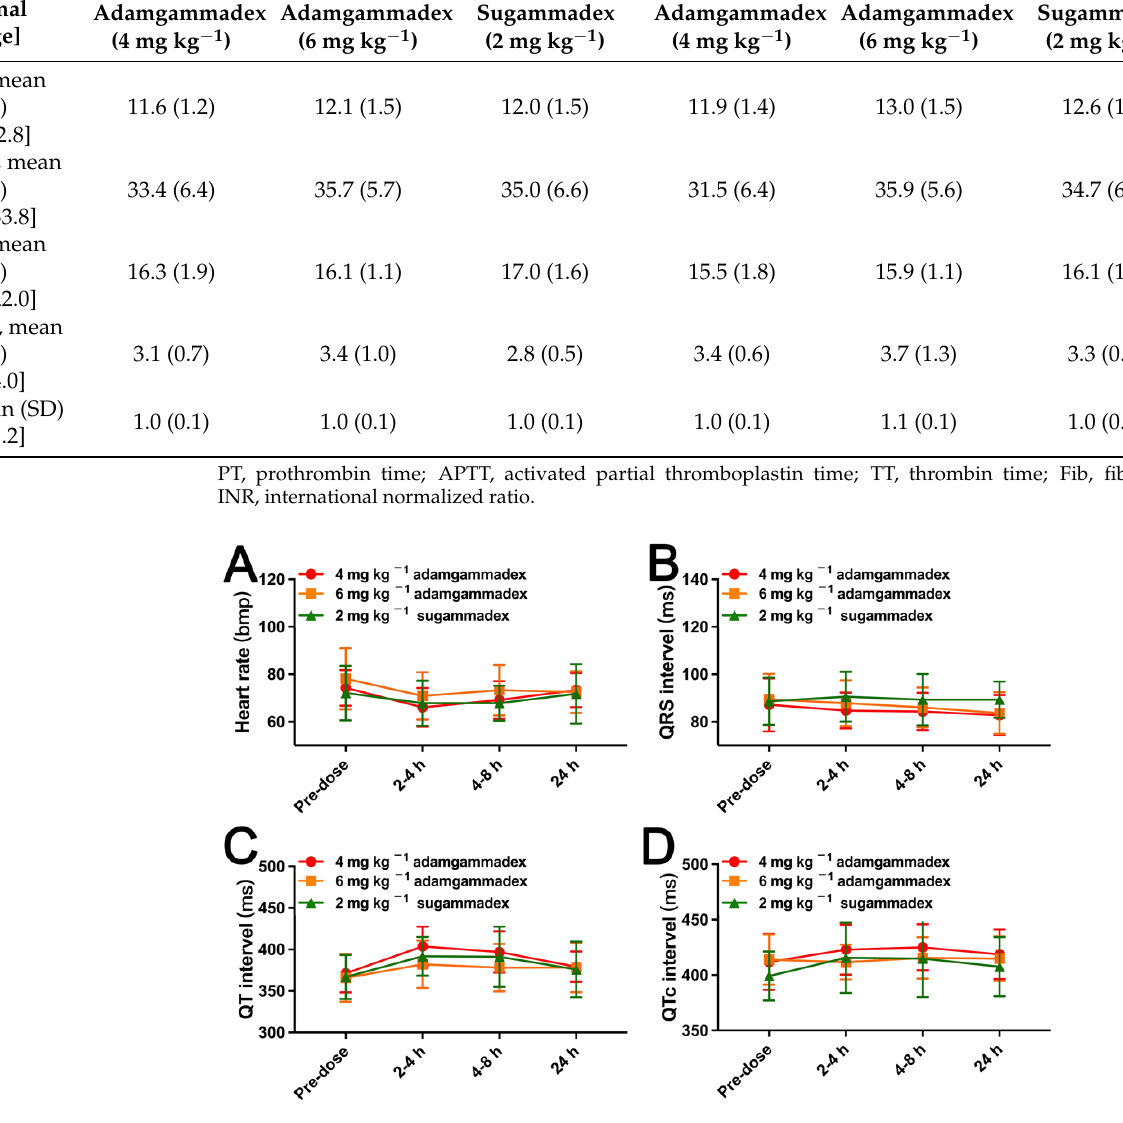
Figure 6. ECG variables, including heart rate ( A ), QRS interval ( B ), QT interval ( C ), and QTc interval ( D ), in patients after injection with adamgammadex or sugammadex. ( D ), in patients after injection with adamgammadex or